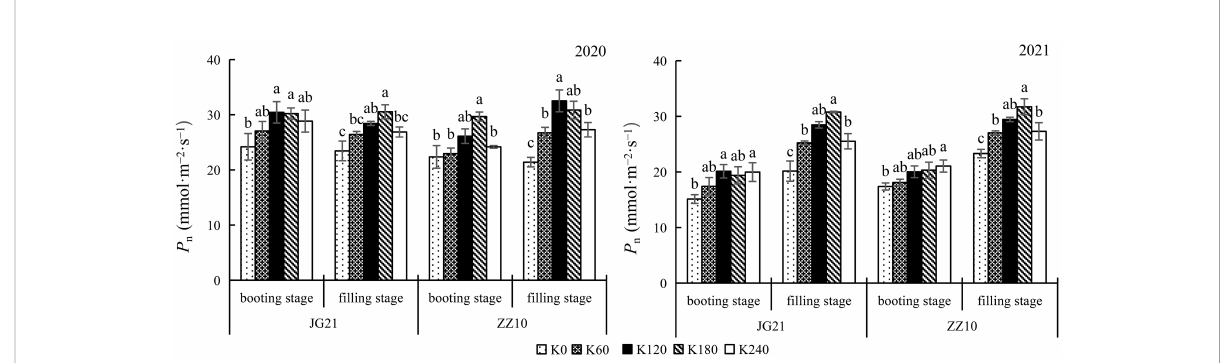
FIGURE 2 Effects of potassium application rate on net photosynthetic rate of foxtail millet cultivars, Jingu 21 (JG21) and Zhangza 10 (ZZ10). Potassium applications include 5 level 0 (K 0 ) as control, 60 (K 60 ), 120 (K 120 ), 180 (K 180 ), and 240 (K 240 ) kg·hm − 2 of K 2 O. The different normal letters indicate signi fi cant differences in different treatments of the same variety at the 0.05 level. Values are means ± SE (n = 3).